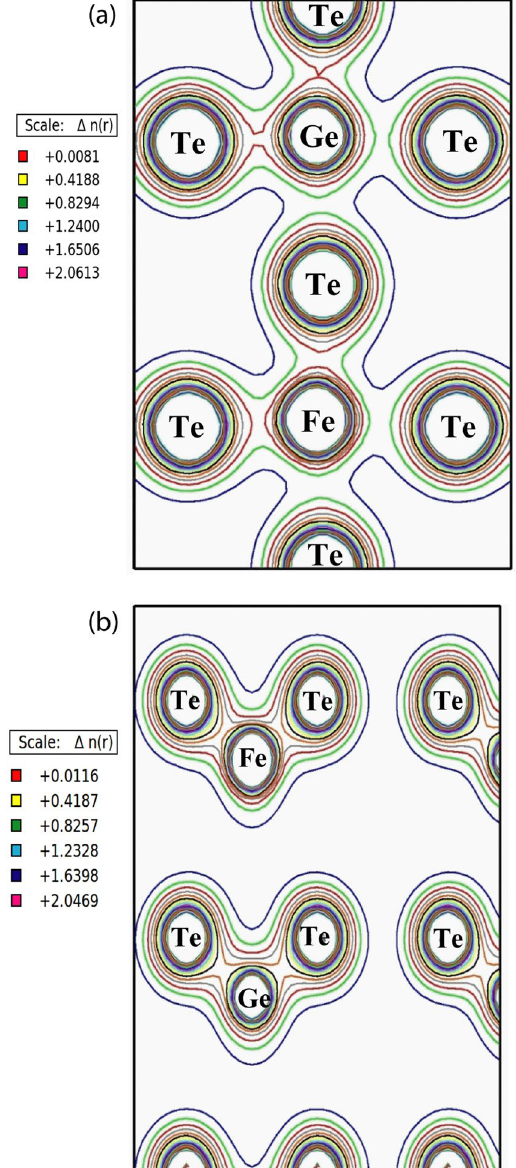
Figure 6. Charge density distribution of Fe-doped GeTe at ( a ) (100) planes of c-GeTe and ( b ) (111) planes of II in Table 2 (i.e. n = 0), it is clear that our experimental data (A component, Table 1) are much better reproduced by the pure tetrahedral GeTe 4 case. It is evident from calculations (Table 2), that the introduction of one and two Te vacancies around Fe Ge in the c-GeTe configuration strongly enhances the quadrupole splitting. In particular, configuration IV) in Table 2 with two Te vacancies yields δ and Δ E Q values matching very well the experimental values for the D component (Table 1), which is characterized by a larger line broadening compared to components A and C (cf. Table 1). Consequently, we assign the D component to the defect-octahedral configuration proposed in ref. 33. In a-GeTe thin films, the fraction of defect-octahedral configuration has been shown to increase with the film thickness, and reported to be ≤ 30% for 100 nm layers 52 . By assuming the trend of the defect-octahedral fraction vs film thick- ness reported in ref. 52, we expect a fraction ≤ 35% in a 150 nm thick GeTe film. In GeTe-2, we detect a 60% of D fraction in a-GeTe (Fig. 4). Therefore, we conclude that our D component consists of two contributions: a ≤ 35% of Fe Ge in the defect-octahedral configuration and a ≥ 25% fraction in a more disordered local configuration (distribution of bond angles and/or additional Te vacancies), due to the lattice damage induced by the implanta- tion process. At the phase transition temperature of 180 °C, the ion-implantation induced damage is expected to disappear 42 . We therefore conclude that the ≤ 20% fraction of D component that is left in c-GeTe (Fig. 4) is due to a persisting fraction of Fe Ge in the defect-octahedral configuration, with the remaining ≥ 20% fraction (A) due to